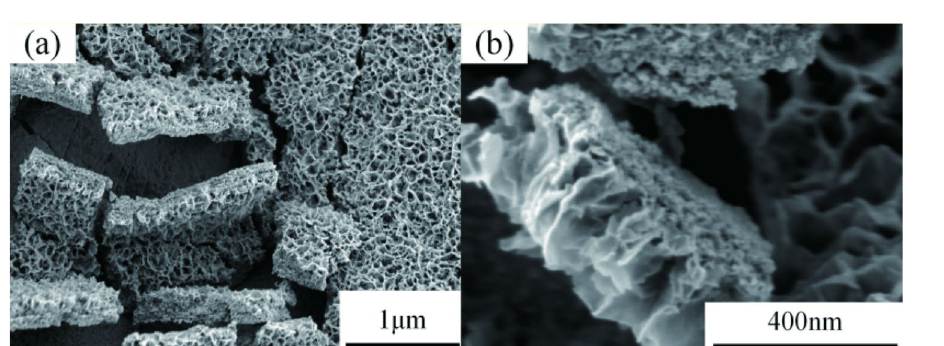
Figure 6. SEM images of pure TiO 2 ( a , d ), NiS/TiO 2 nanocomposite with 6 NiS impregnation-deposition cycles ( b , e ) and Ag/NiS/TiO 2 nanocomposite with 6 NiS impregnation-deposition cycles performed at a AgNO 3 concentration of 0.1 M ( c , f ).